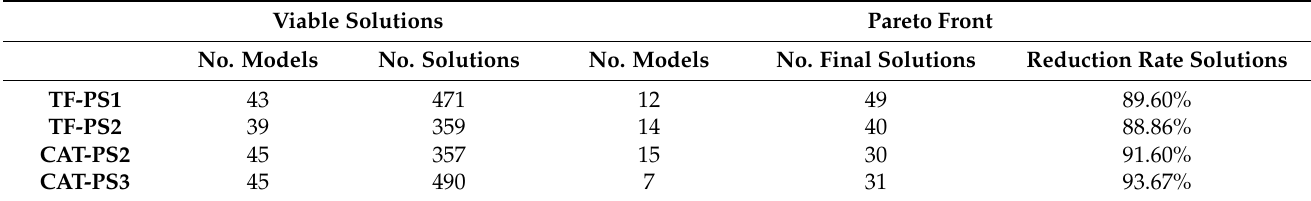
Table 7. Number of viable pumps and solutions numbers for every